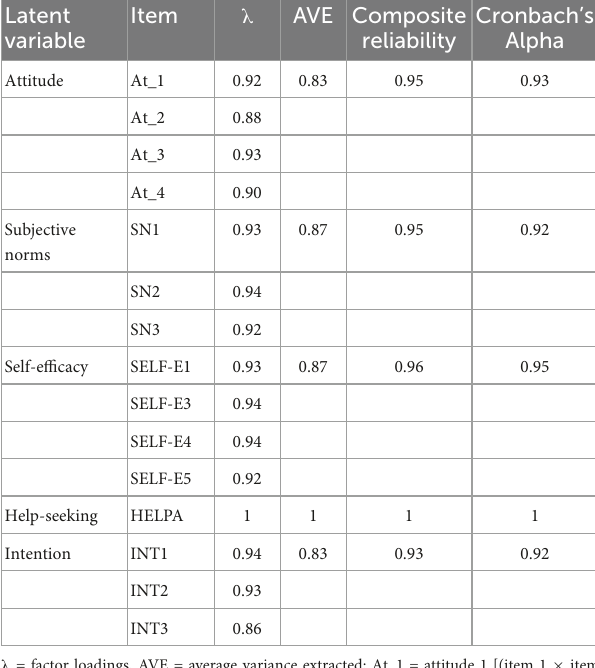
TABLE 5 Descriptive and Pearson’s correlations between